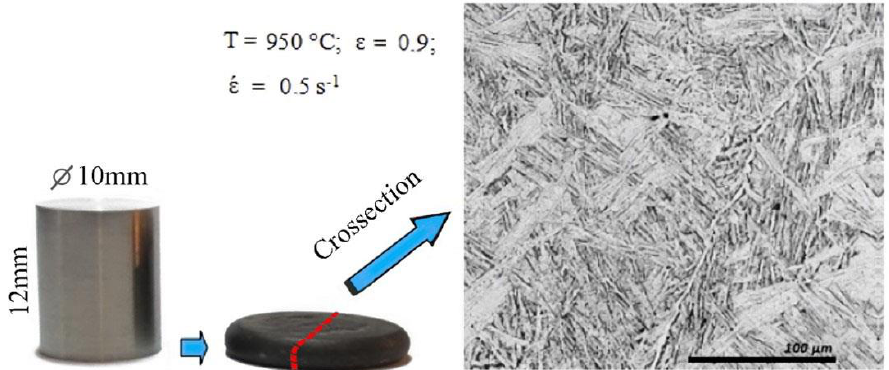
Figure 8. Sample for plastometric study Ø10 × 12 mm of M5 alloy and its structure after plastometric testing at T = 950 °C and έ = 0.5 s −1 .